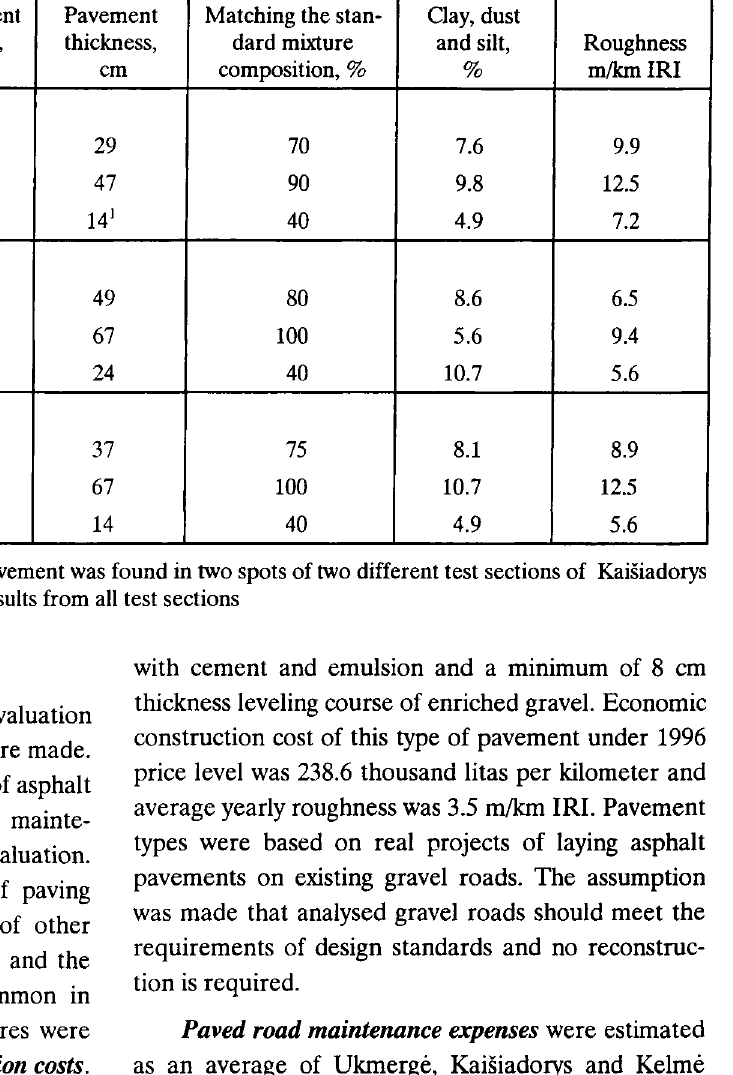
Table 1. Results of the major parameters of Lithuanian gravel roads condition research Studied parameters Pavement Pavement Matching the stan· Clay, dust and test regions AADT, width, thickness, dard mixture and silt, Roughness veh/day m em composition, % %